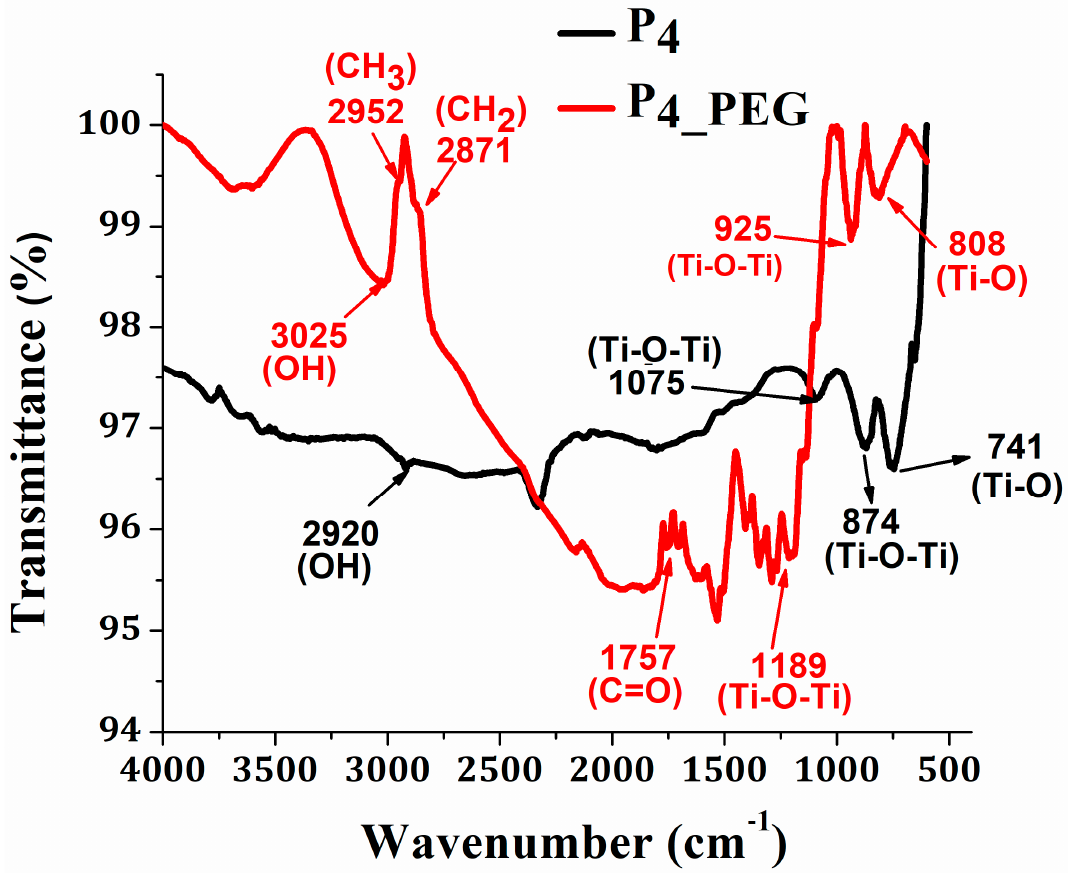
Figure 7. FTIR spectra of TiO 2 thin fi lms obtained from sol–gel solution with/without PEG.